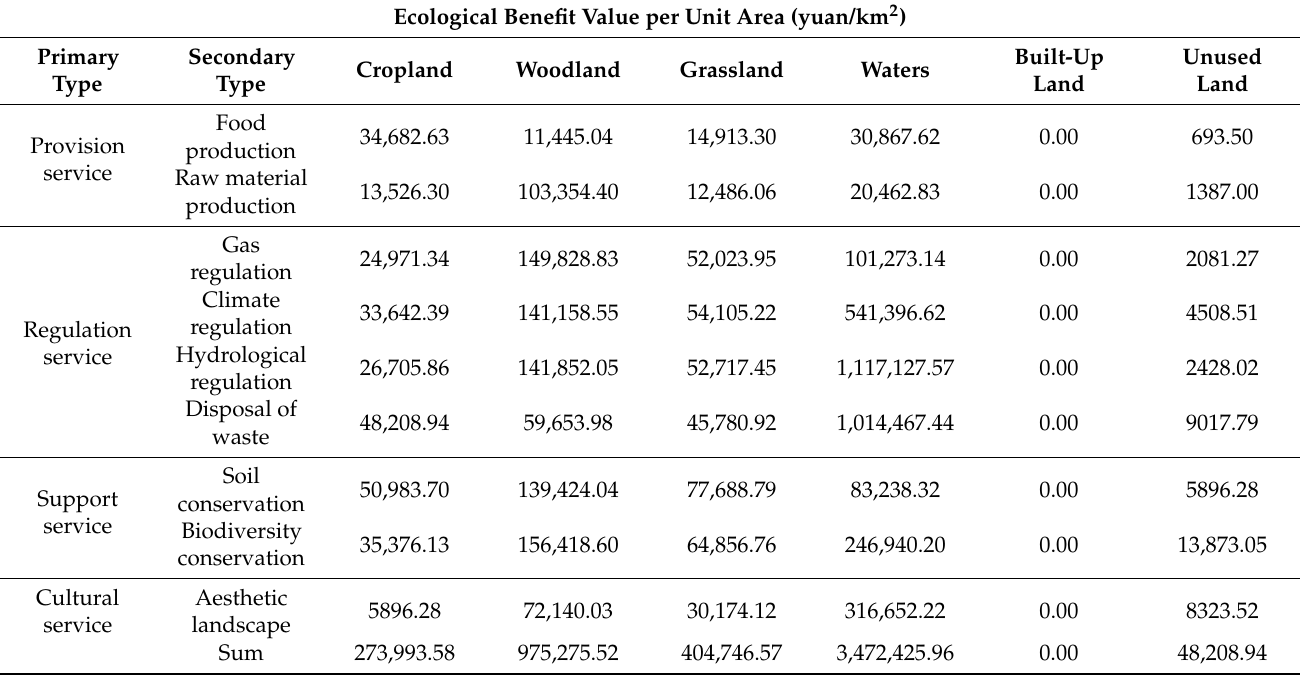
Table 3. Correspondence of land use types. Types of Land Use in this Research Types of Land Use in Reference [29] Cropland Cropland Woodland Forest Grassland Grassland Waters Wetlands, rivers/lakes Built-up land - Unused land Deserts I E represents the land use ecological benefit (yuan). ESV k represents the ecological benefit’s value per unit area of the k-th of land use (yuan/km 2 ). VC ki represents the ecosystem service value of the k-th type of land use and the i-th type of function per unit area of the Chinese ecosystem (yuan/km 2 ) [29]. S represents the biomass factor adjustment coefficient, and the calculated value is 1.00. PI represents the socio-economic factor adjustment coefficient and the calculated result is 0.77. Ecological benefits calculated per unit area (Table 4) by Equation (6). Table 4. The value of ecological benefits per unit area of the Yellow River Basin from 1995 to 2018. Ecological Benefit Value per Unit Area (yuan/km 2